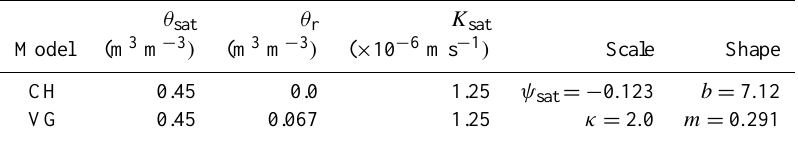
Table 5. Silty loam soil hydraulic parameters for different models used for Fig. 7. Parameters are adapted from Shao and Irannejad (1999). θ sat θ r K